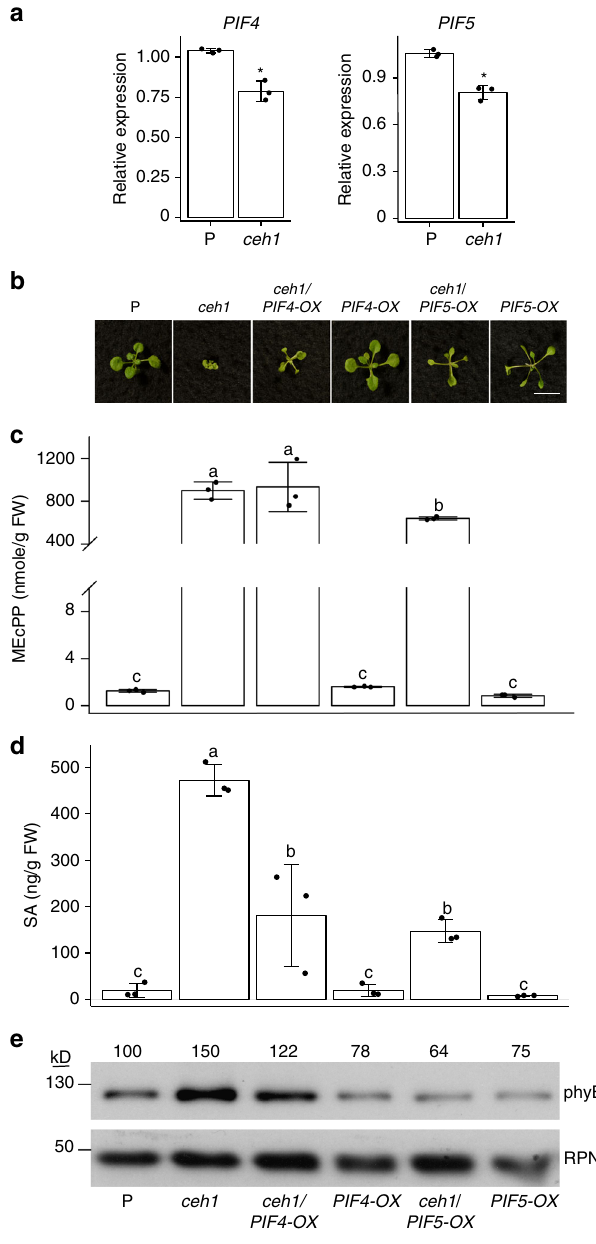
Fig. 4 PIF4 and PIF5 overexpression mimics phyB revertants phenotypes. a